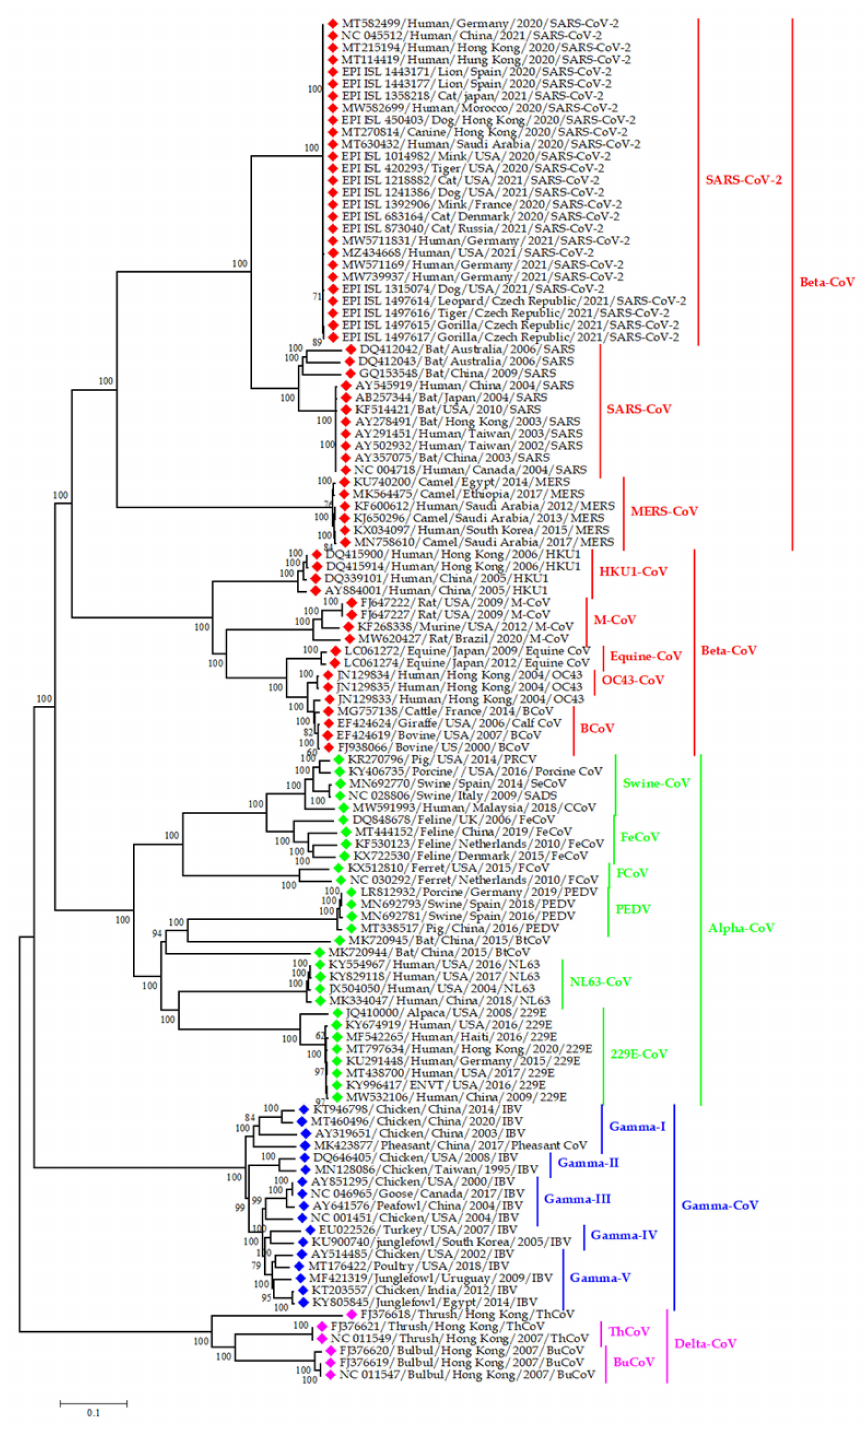
Figure 2. Phylogenetic analysis of CoV sequences from both animals and humans; green, red, blue, and pink color denotes alpha, beta, gamma, and delta coronaviruses, respectively. We constructed the phylogenetic tree representing the evolutionary relationship between all types of reported CoV in domestic animals, wildlife and human. This coronavirus family tree covering all four CoV genera; Alpha, beta, gamma and delta CoV. Both alpha and beta CoV genera segregated in various coronavirus strain like SARS-CoV, SARS-CoV-2, NL63, MERS-CoV, HKU1-CoV, OC43 etc. From this point of view, we have taken the various representative animals and human originated CoV sequences based on time and space for understanding the evolutionary relationship among all of the